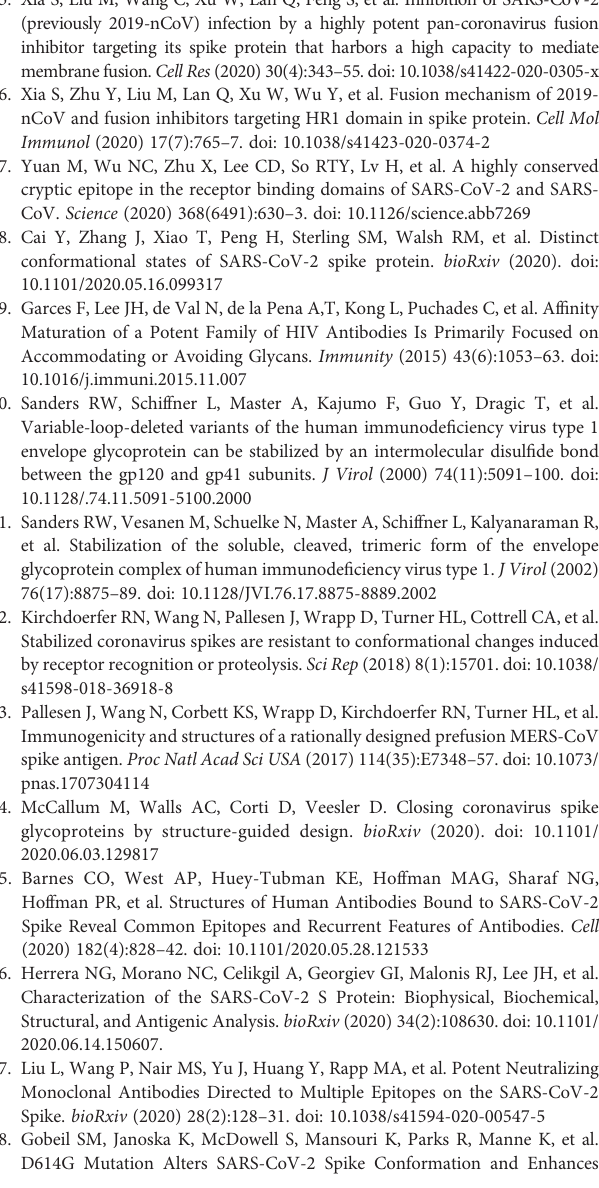
Supplementary Figure 1 | Mapping the SEC Peak of the Spike Trimer. Evaluation of SEC fractions (indicated by purple circles) by negative stain EM and reducing SDS-PAGE gels to discriminate aggregates, trimers, and free Spike protomers. White circles highlight individual particles. Supplementary Figure 2 | Low Resolution Models of the Spike Trimer Approximate High Resolution Cryo-EM Structures. Docking the full-length Cryo-EM structure (PDB: 6VSB) into the low-resolution 3D reconstruction of the Spike_KV model (A) .Dockingofasingle protomer (B) .DockingoftheS2subunit (C) .Docking illustrations were generated using PDB 6VSB. Supplementary Figure 3 | Sequence Diversity of Coronaviruses Mapped onto the SARS-CoV-2 Spike Trimer. 1661 Coronavirus sequences (from NCBI with search parameter: Coronaviridae : Coronavirus) mapped onto the SARS-CoV-2 Cryo EM structure (PDB: 6VXX). Residues are colored by % identity according to the diagram below the